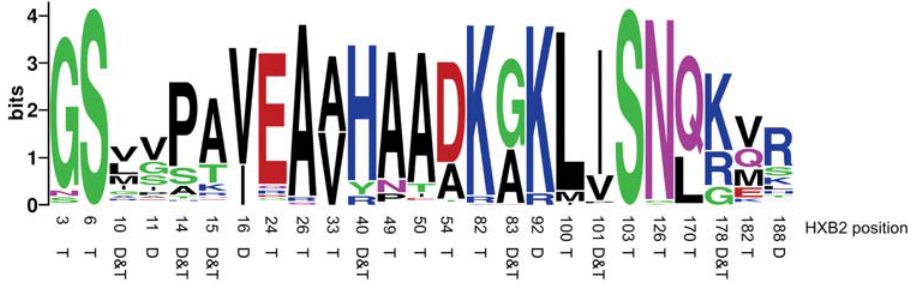
Figure 5. Amino acid diversity at positively selected sites. Amino acid sequence logos [73] of positively selected sites, diversifying selection (D), toggling (T), or both (D&T), indexed by HXB2 position in nef are shown.